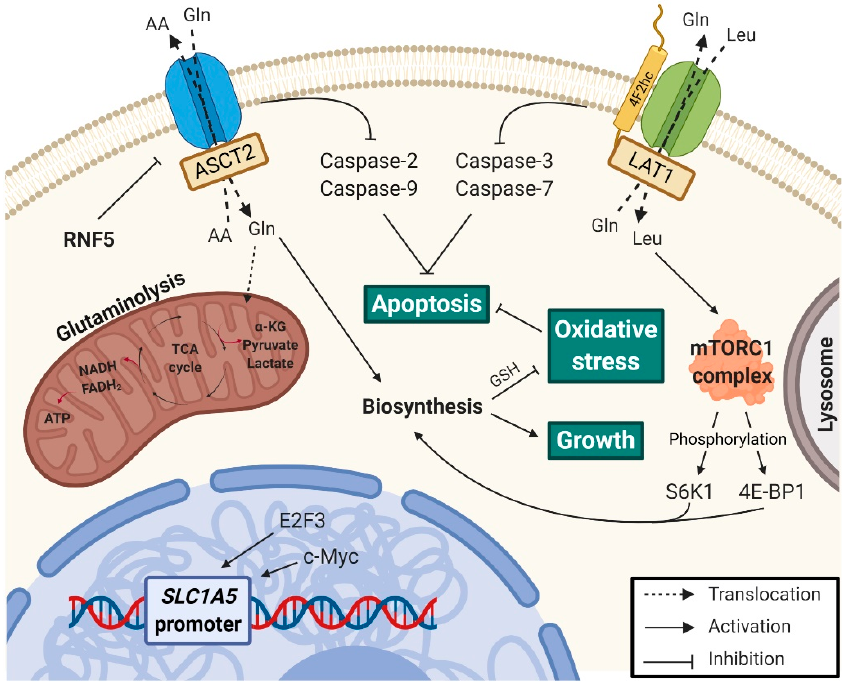
Figure 4. Pathways affected by ASCT2 and LAT1. ASCT2 is responsible for the transport of neutral amino acids into the cell, namely glutamine (Gln), coupled with the transport of one neutral amino acid (AA) to the extracellular environment. Gln can be used to synthesize glutathione (GSH), an antioxidant which prevents oxidative stress. In turn, together with ASCT2-related downregulation of caspases-2 and -9 and LAT1-related downregulation of caspases-3 and -7, oxidative stress inhibits apoptosis. On the other hand, Gln can also be used to biosynthesize other elements that play key roles in cell growth or be transported to the mitochondria and enter the glutaminolysis process, yielding metabolites, such as α -KG, pyruvate and lactate, and generating NADH and FADH 2 , es- sential for ATP production. Similar to ASCT2, LAT1 is an amino acid exchanger, transporting one amino acid into the cytosol, like leucine (Leu), and another amino acid to the extracellular milieu, namely Gln. Leu is required for the activation of the mammalian target of rapamycin complex (mTORC1), which in turn activates the downstream effectors ribosomal protein S6 kinase 1 (S6K1) and eukaryotic translation initiation factor 4E-binding protein 1 (4E-BP1) through phosphorylation. Those proteins play important roles in mRNA and protein biosynthesis, resulting in cell growth. In the nucleus, proto-oncogenes and tumor suppressors, such as c-Myc and E2F transcription factor 3 (E2F3), respectively, have been found to bind to promoter elements of the gene encoding ASCT2, resulting in altered Gln metabolism through SLC1A5 dysregulation (created with BioRender.com).